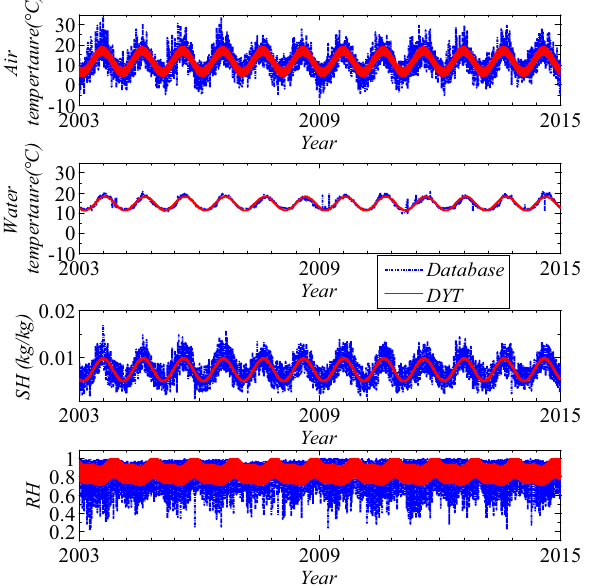
Fig. 2 Climate database and daily yearly-based climate model for Brest.